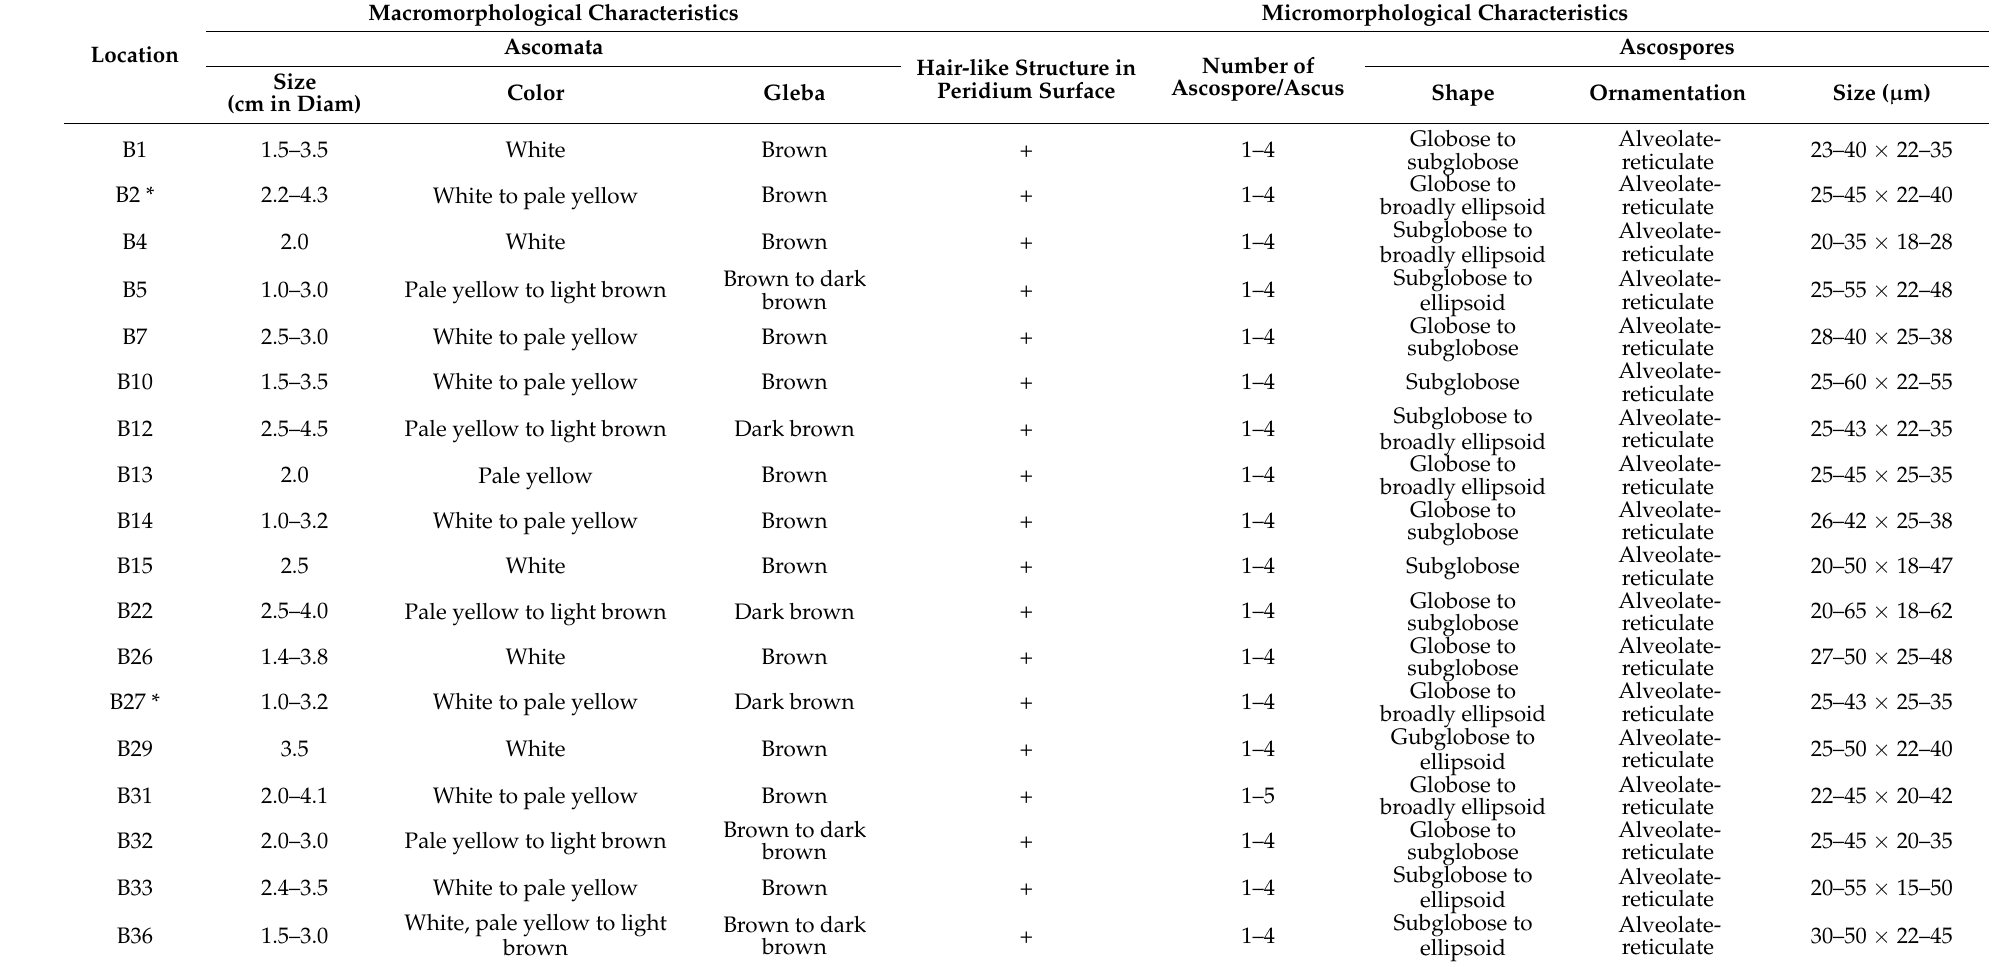
Table 3. Morphological characteristics of truffles collected from each truffle OTU’s representative location in this